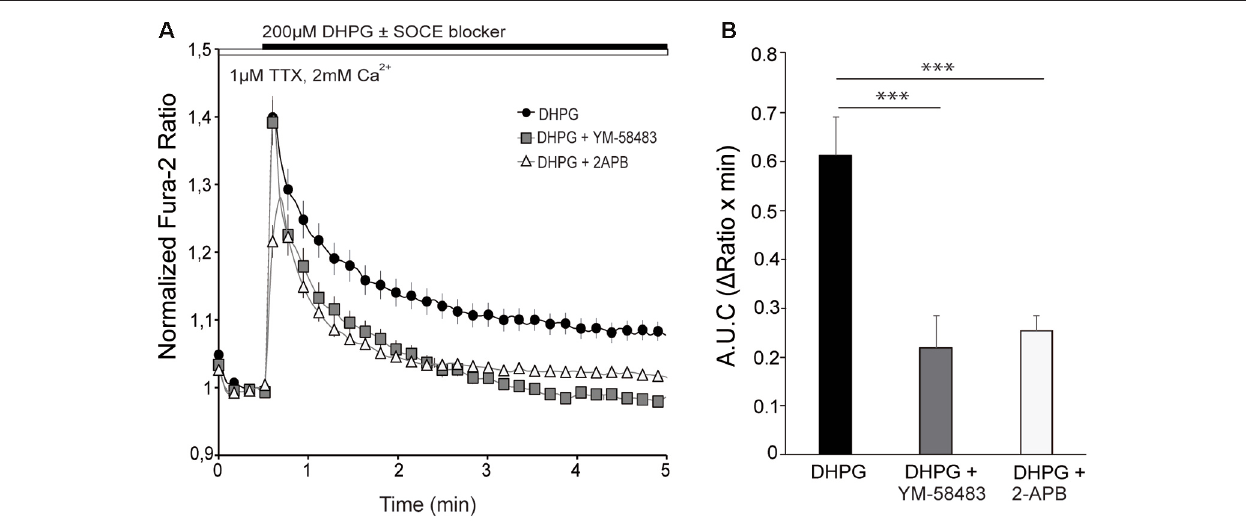
FIGURE 3 | SOCE is involved in metabotropic glutamate receptors (mGluRs)-driven Ca 2 + signal. (A) Fura-2 [Ca 2 + ] i signals in cortical neurons in HCSS medium containing 2 mM CaCl 2 and 1 µ M tetrodotoxin (TTX) upon addition of 200 µ M (S)-3,5-dihydroxyphenylglycine (DHPG) ± 10 µ M YM-58483 or 50 µ M 2-APB were indicated. (B) Quantification of area under the curve ( ∆ Ratio · min) after DHPG ± YM-58483 or 2-APB addition. Data were obtained from three independent experiments ( n = 3), and in each one a total of 25–30 cells were analyzed. All data are expressed as mean ± SEM and means were compared using one-way ANOVA, ∗∗∗ p < 0.001, post hoc Bonferroni